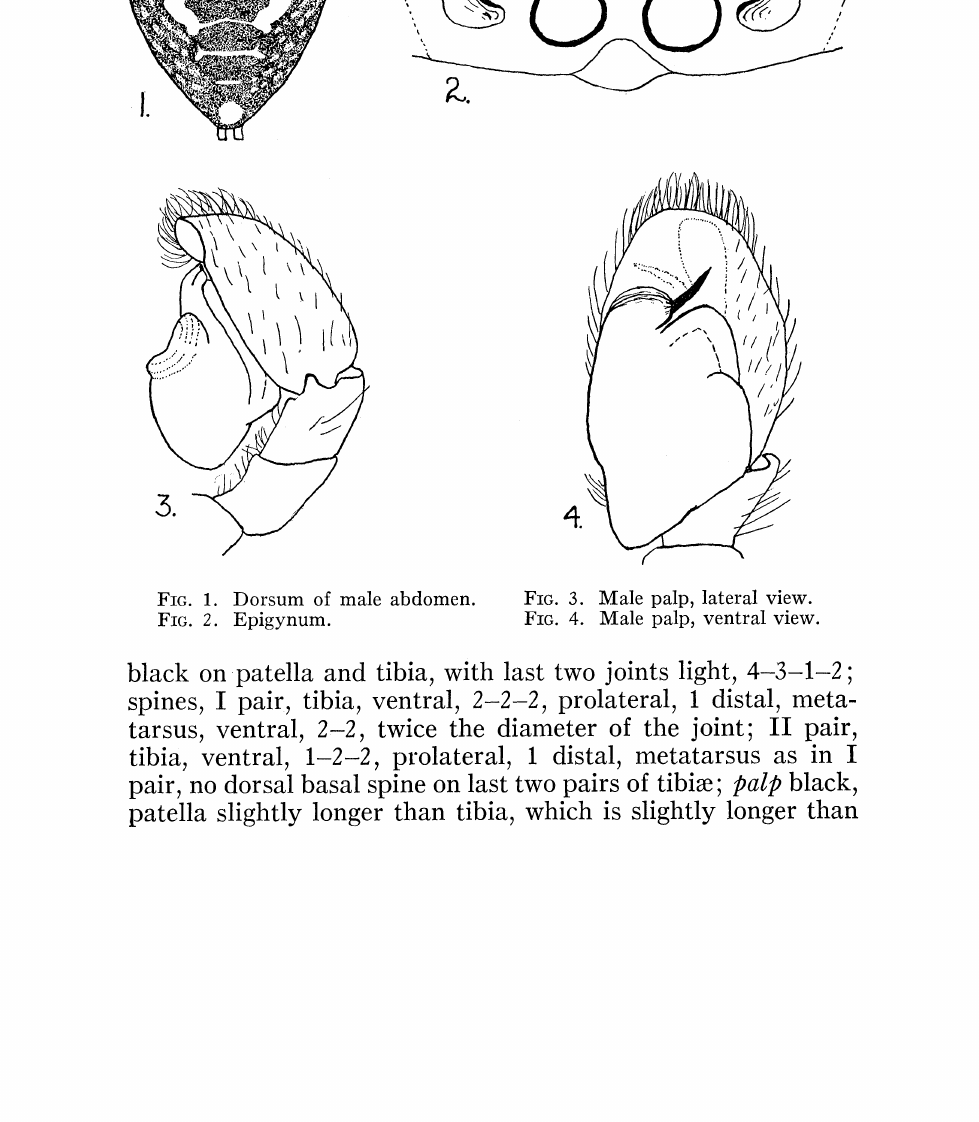
FIG. 3. Male palp, lateral view. FIG. 4. Male palp, ventral